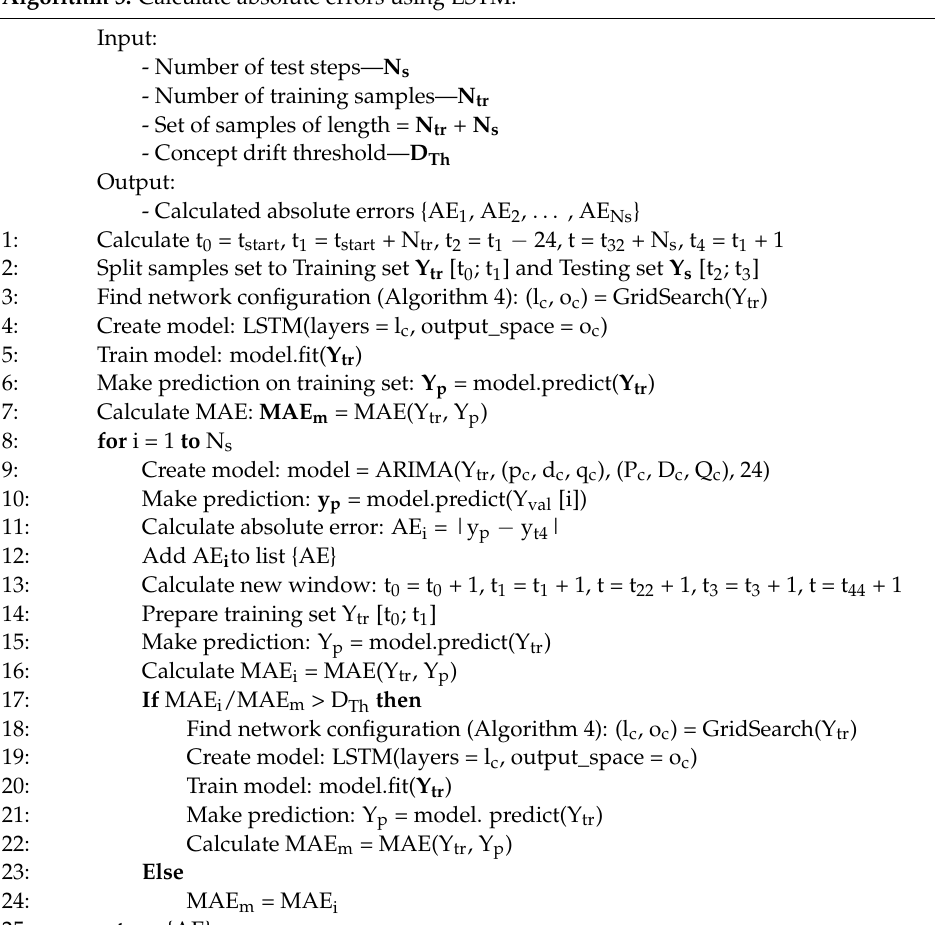
Algorithm 5: Calculate absolute errors using